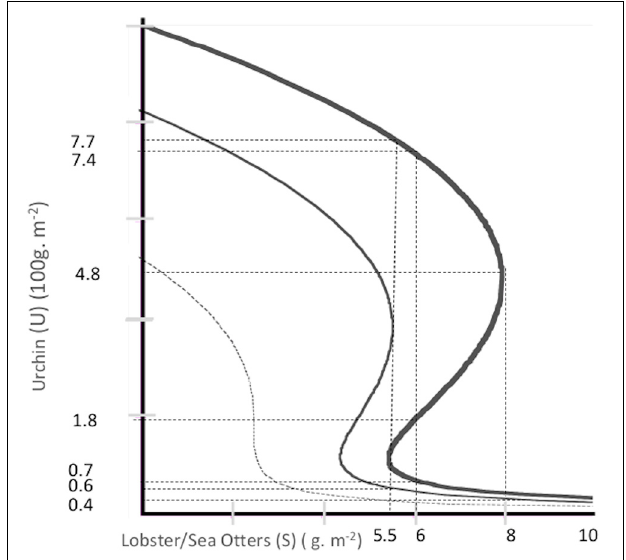
FIGURE 2 | Predator-urchin subsystem isoclines: The cubic equation for the ˙ U = 0 isocline is U 3 − 12 . 5 α U 2 + ( 1 + 3 . 25 S ) U + 1 . 25 α = 0. Varying α , α = 0.42- lower dashed curve, α = 0.66-middle normal weight curve, α = 0.8-upper heavy weight curve.